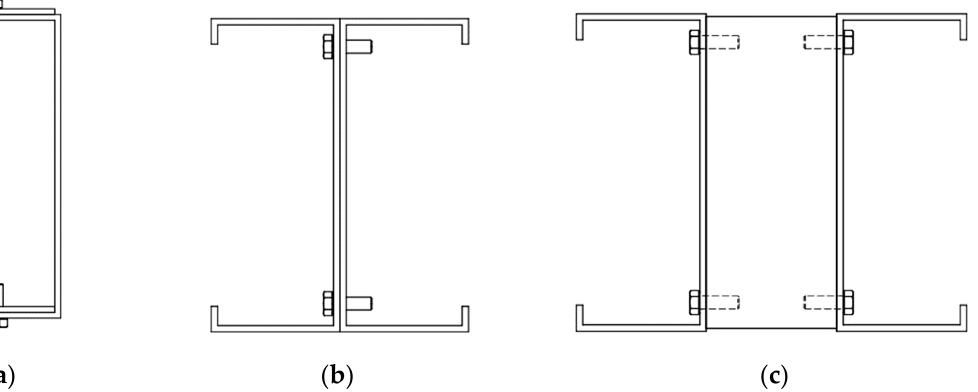
Figure 3. ( a ) Face-to-face connected box-section; ( b ) back-to-back built-up I-section; ( c ) back-to-back gapped built-up channel sections.